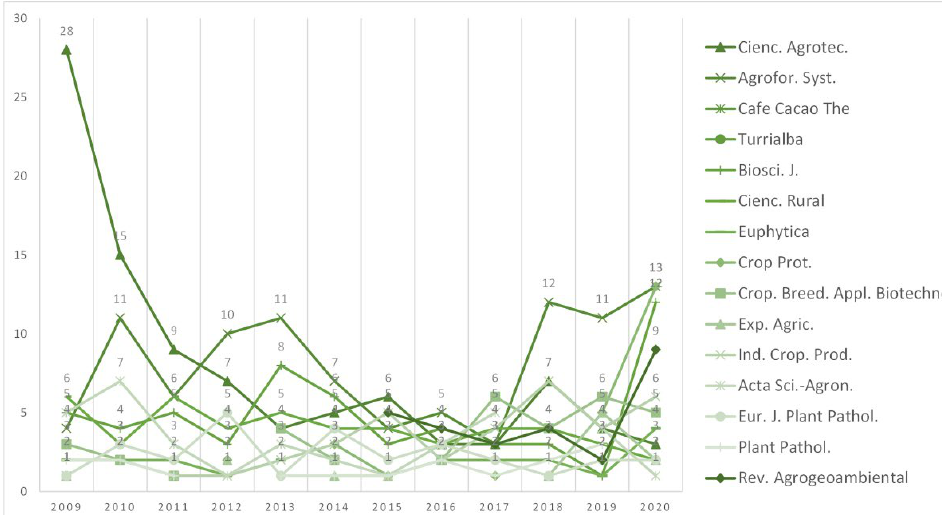
Figure 2. Publications on coffee agronomy in journals from major Bradford zones (2009–2020).